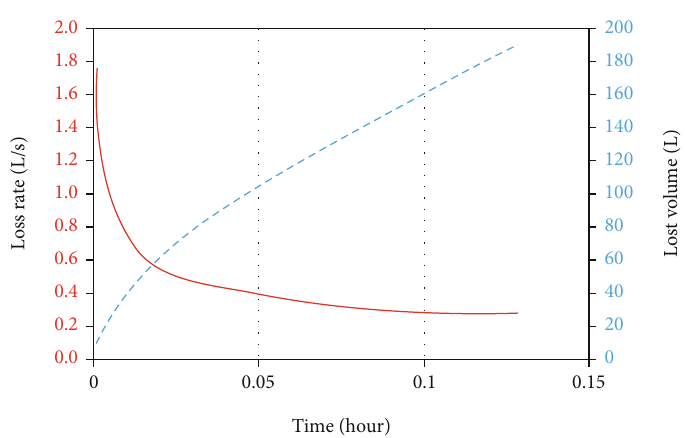
Figure 8: The trends of loss rate and cumulative volume for pipe fl ow type of lost circulation.